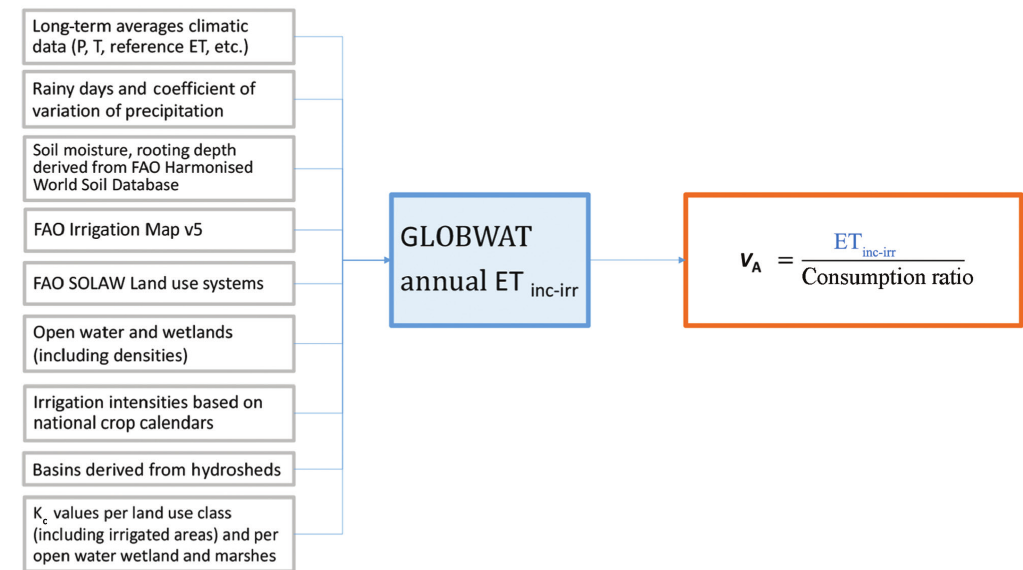
Assessing SDG indicator 6.4.2 ‘level of water stress’ at major basins level